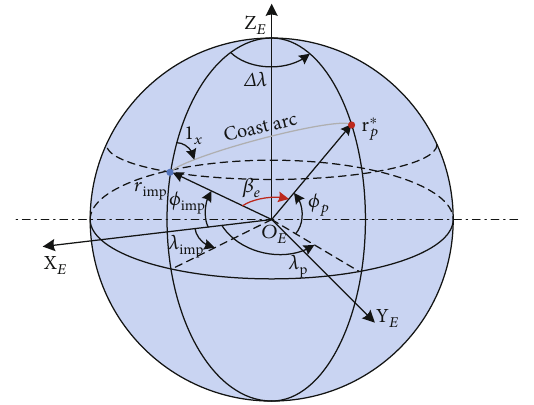
Figure 4: Calculation target orbit composed of the equivalent pulse and the desired instantaneous impact point. point P imp